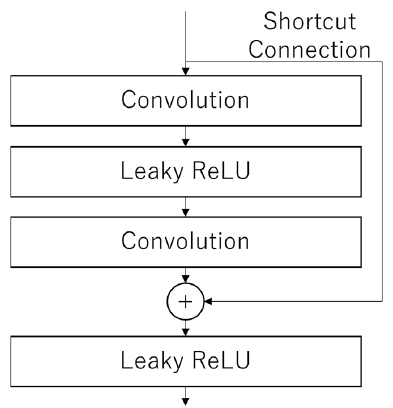
Figure 5. Residual block architecture.